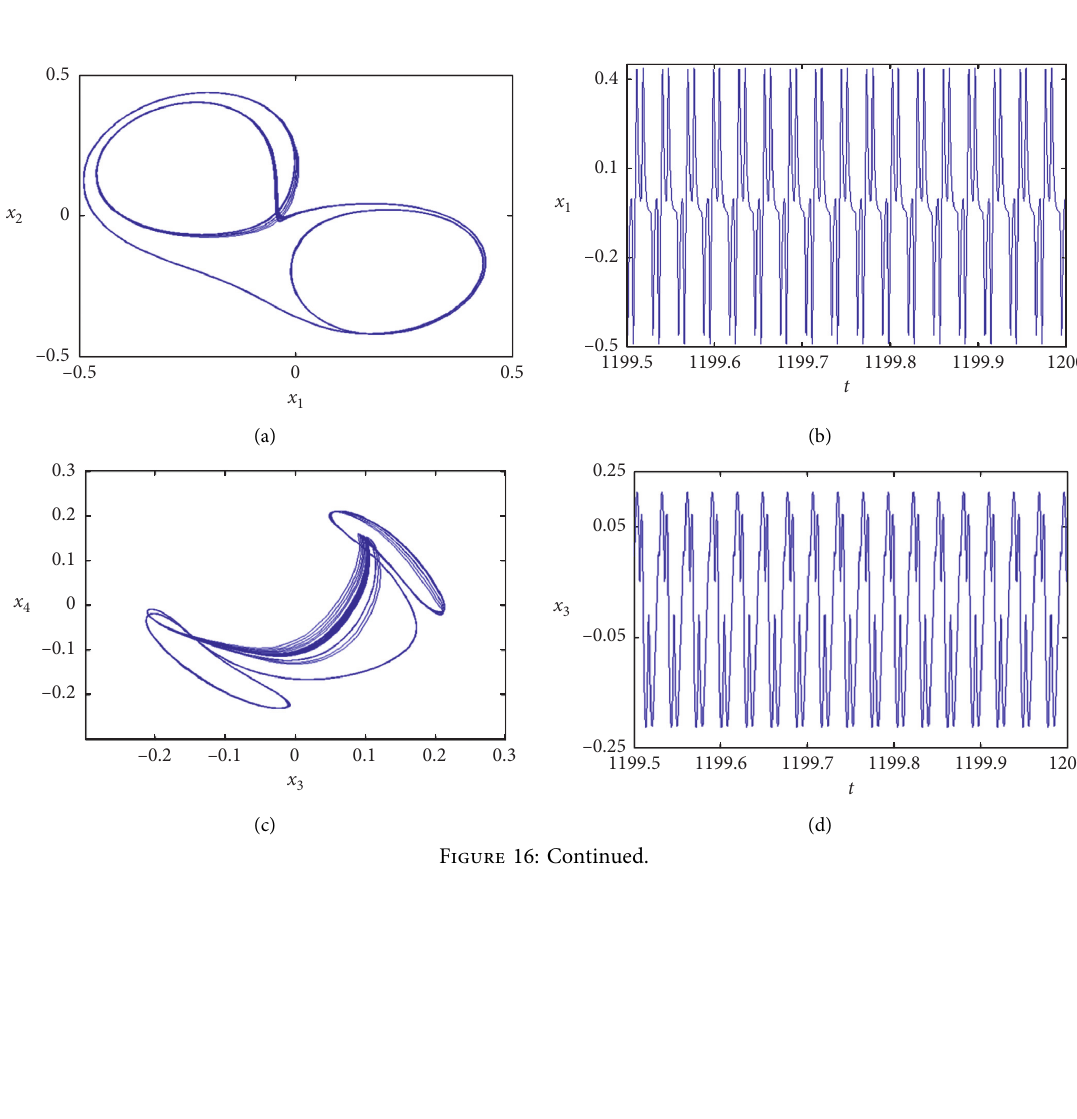
,x ) , (d) waveform on plane 3 4 ,x ) . 1 2